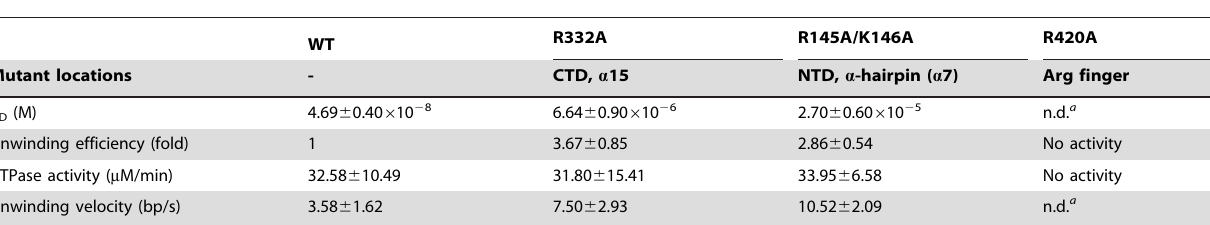
Table 2. Enzymatic activities of wild-type and mutant Gk DnaC helicases.